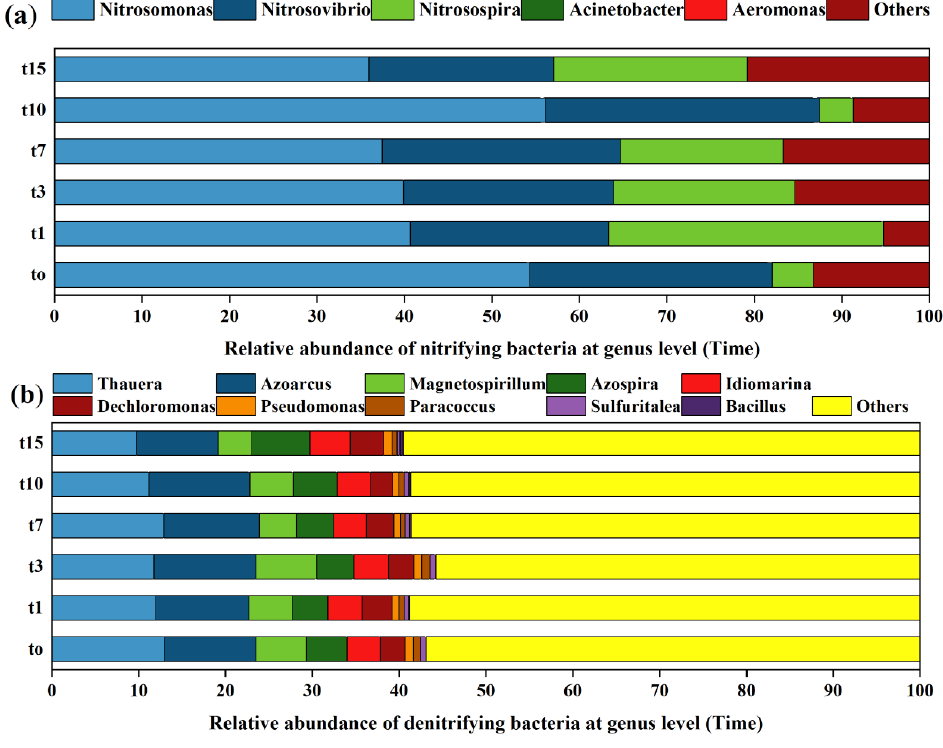
Figure 6. At genus level, species composition of nitrifying bacteria ( a ) (amoA gene) and denitrifying bacteria ( b ) (NirS gene) at different times.